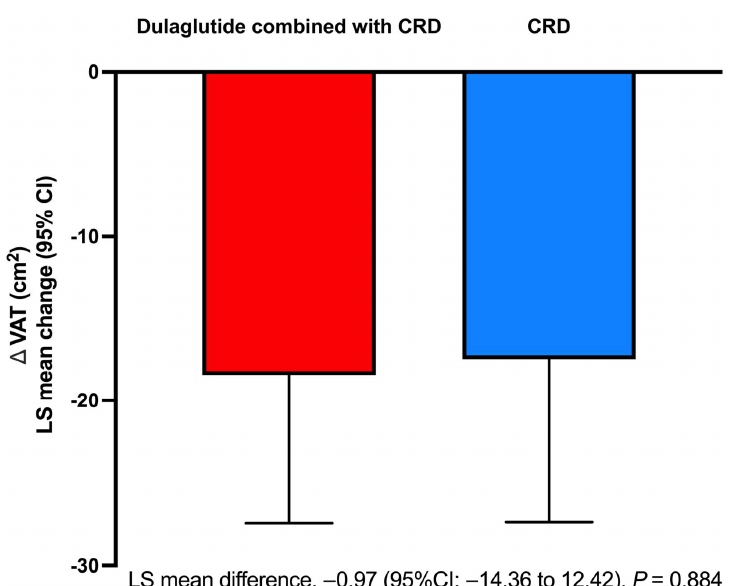
Figure 3. The change in VAT area from baseline to reach 7% weight loss of initial body weight in the intention-to-treat population. HR, hazard ratio; LS, least-squares; VAT, visceral adipose tissue; CRD, calorie-restricted